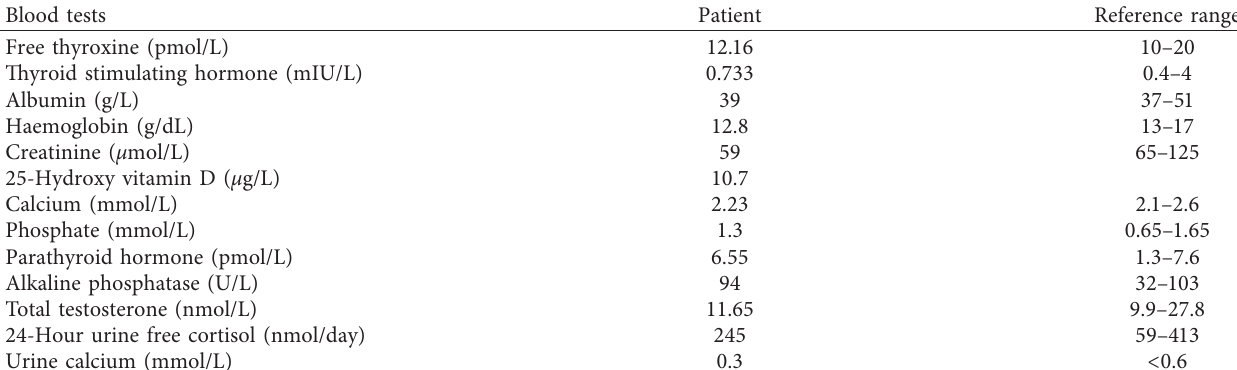
Figure 1: X-ray and MRI. (a) X-ray of the patient’s legs showed cortical irregularity and lucency with sclerotic margins in the proximal shaft of the tibia, confirming stress fractures. (b) MRI of the calves of the patient showed increased signal at linear T1RM sequence which suggests fluid clefs at both fracture sites. Table 1: The summary of investigations performed to evaluate secondary causes of